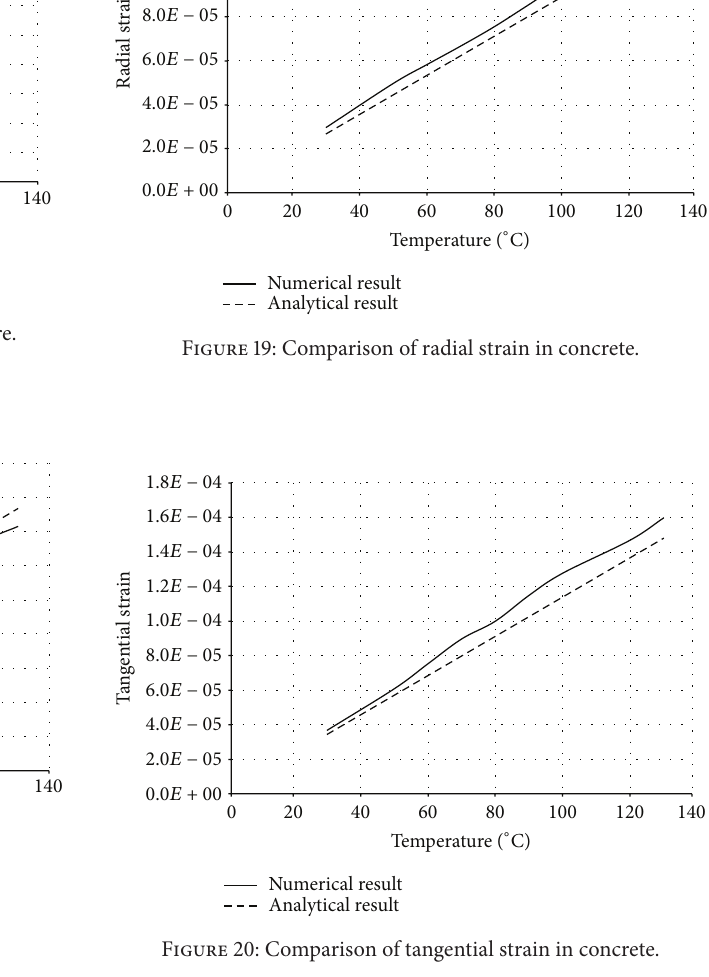
Figure 20: Comparison of tangential strain in concrete.